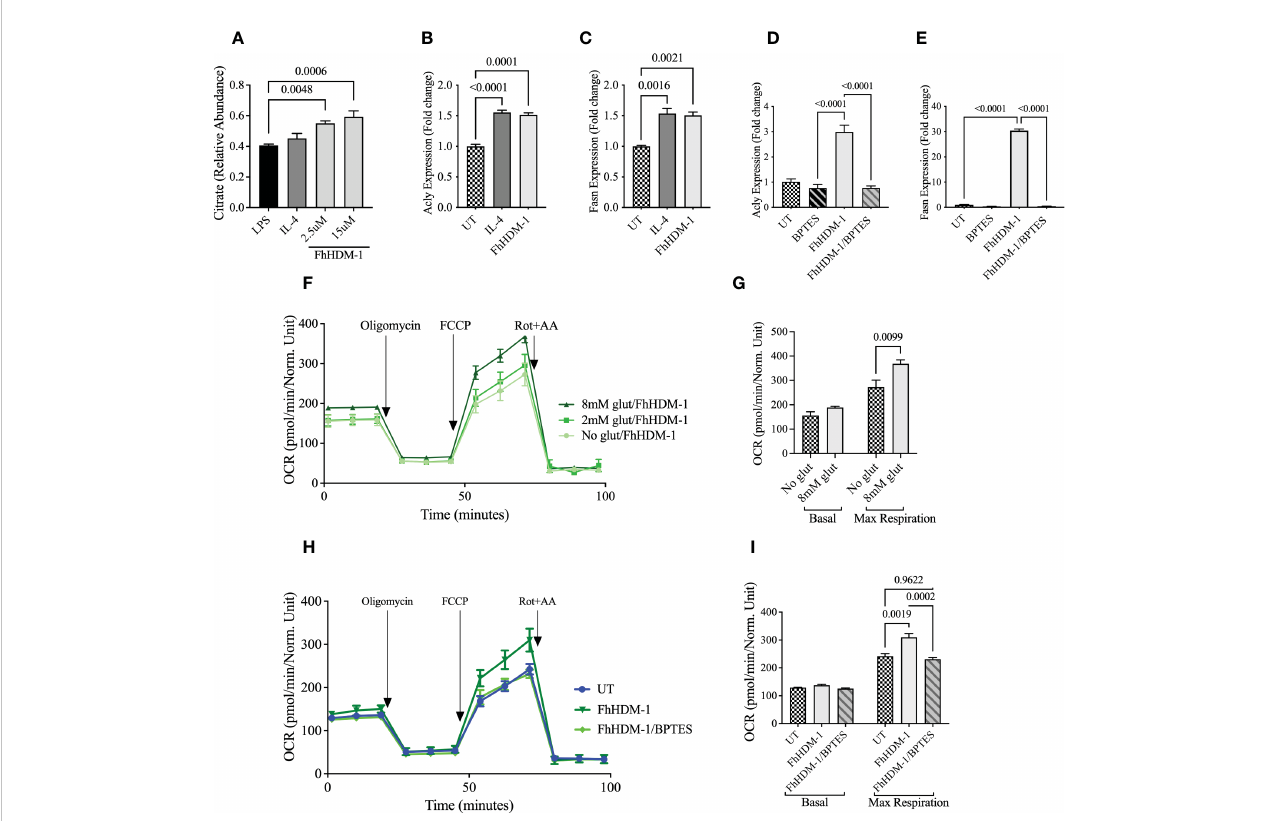
FIGURE 3 Oxidative phosphorylation induced by FhHDM-1 is fuelled by endogenous fatty acids synthesised via glutaminolysis. (A) BMDMs were treated with LPS (20ng/mL), IL-4 (20ng/mL) or FhHDM-1 (2.5µM and 15µM). The intracellular levels of citrate were quanti fi ed by mass spectrometry after metabolite extraction (n=6), and (B – E) The differential expression of Acly and Fasn was quanti fi ed by qRT-PCR in lysates of cells (n=3) that were untreated, or treated with IL-4, FhHDM-1(2.5µM), or a combination of FhHDM-1 and the glutamate inhibitor, BPTES (10µM), for 6h. (F) Glutamine dependency was determined by measuring the OCR in BMDMs treated with FhHDM-1 (2.5µM) for 6h in glutamine replete (2mM or 8mM) or depleted media for 18h (n=4). The basal oxygen consumption rate (OCR) was initially determined, and then measured following sequential treatments with oligomycin, FCCP, and rotenone/antimycin A (Rot+AA) to determine (G) the maximum respiratory capacity of cells. (H, I) The requirement for glutamine by FhHDM-1 treated cells was validated by measuring the (H) OCR and the (I) maximum respiratory capacity in BMDMs cultured in media (UT), or in the presence of FhHDM- 1 (2.5µM) or a combination of FhHDM-1 and the glutamate inhibitor, BPTES (10µM), for 18h. Statistical signi fi cance was determined by a one-way ANOVA with Tukey ’ s multiple comparison test. Data is representative of three independent experiments and is presented as means ±